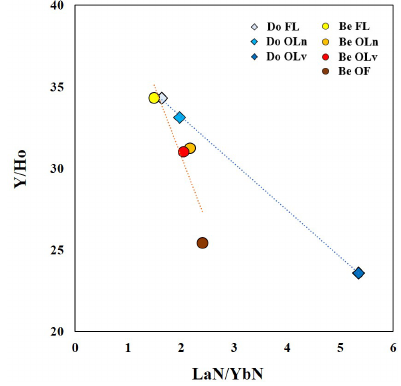
Figure 6. Y / Ho vs. La N / Yb N ratios of fresh leaves and litter sam- ples of Douglas-fir (blue scale) and European beech (red